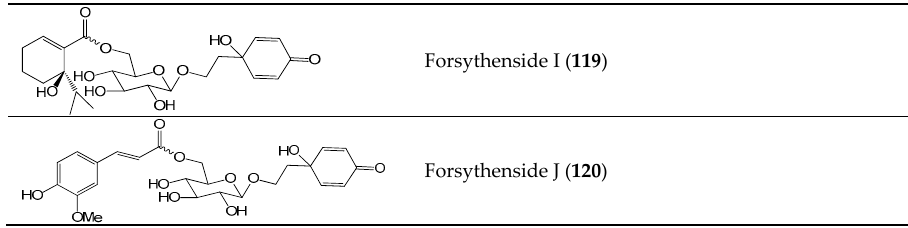
Figure 3. Chemical structures of natural alcohols with the C 6 -C 2 skeleton in Forsythiae Fructus.